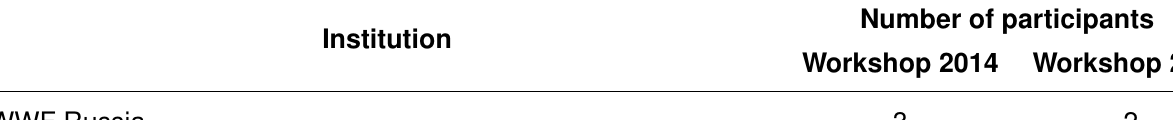
Table 2. Number of experts and affiliated institutions that participated in the two ECOSEFFECT-workshops.